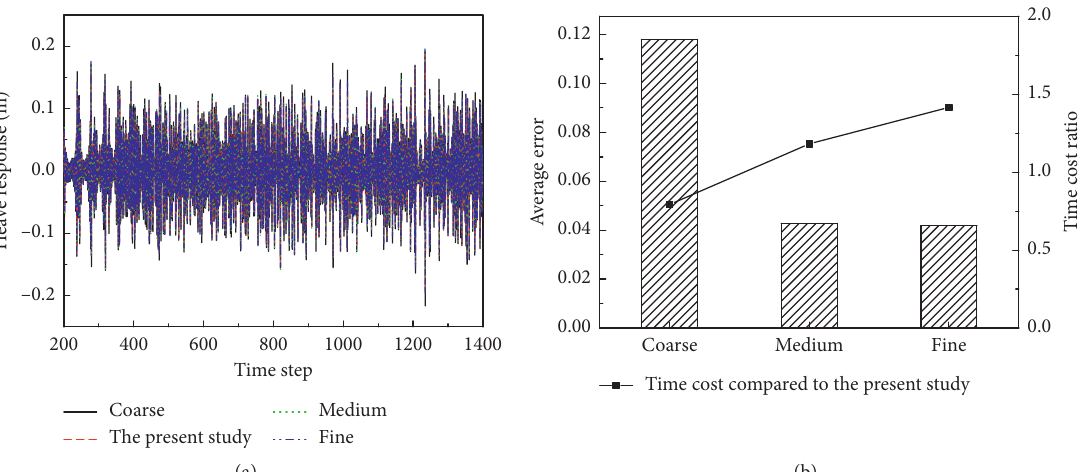
Figure 7: The heave response comparisons of different mesh methods: (a) the time series of heave displacement and (b) the average error and time cost ratio statistics compared to the present study. Table 7: RMS of heave response of different mesh methods. Case Coarse Present study Medium Fine Z